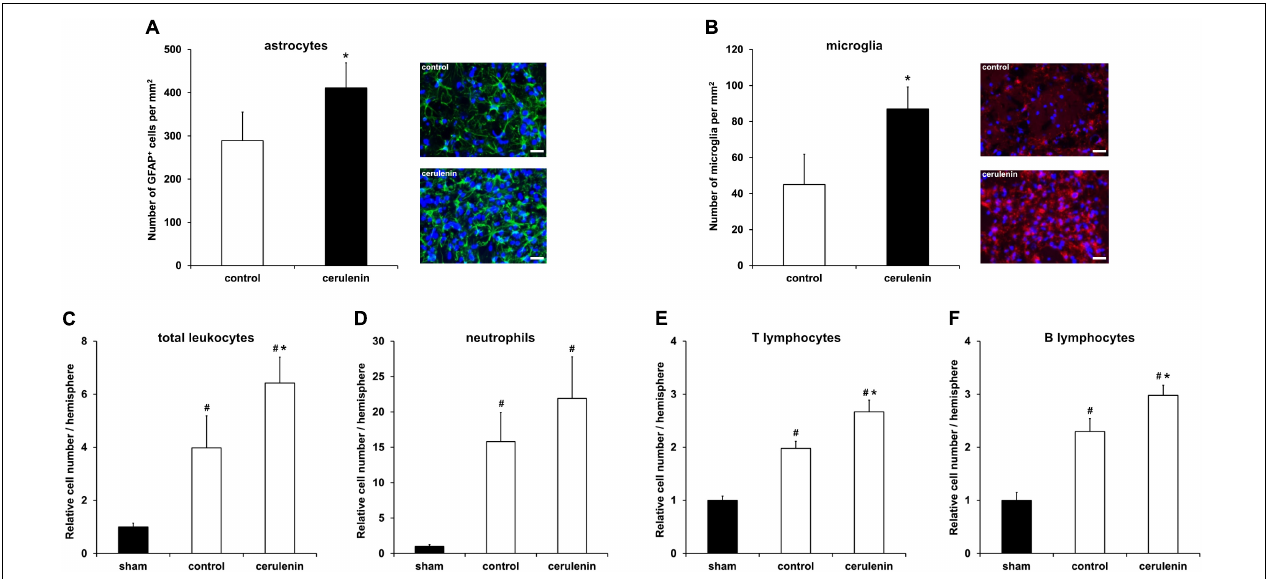
FIGURE 6 | FAS inhibition stimulates poststroke inflammatory responses in vivo . Mice were exposed to middle cerebral artery occlusion (MCAO) and allowed to survive for 7 days after induction of MCAO ( n = 11 per condition). The animals received either cerulenin or DMSO as control, as explained in detail in “Materials and Methods” section. Immunohistochemical analyses for astroglia and microglia was performed using either GFAP ( A , green) or Iba1 staining ( B , red). DAPI counterstaining (blue) was performed in parallel. Scale bars are 50 µ m. Using flow cytometry, the numbers of total leukocytes (C) , neutrophils (D) , T lymphocytes (E) and B lymphocytes (F) were measured on day 7 in ischemic hemispheres. *Significantly different from controls, p < 0.05. # Significantly different from sham mice, p <